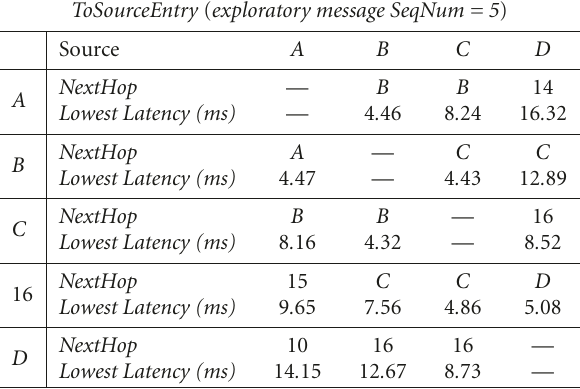
Figure 7: ToSourceEntry setup after exploratory messages flooding.